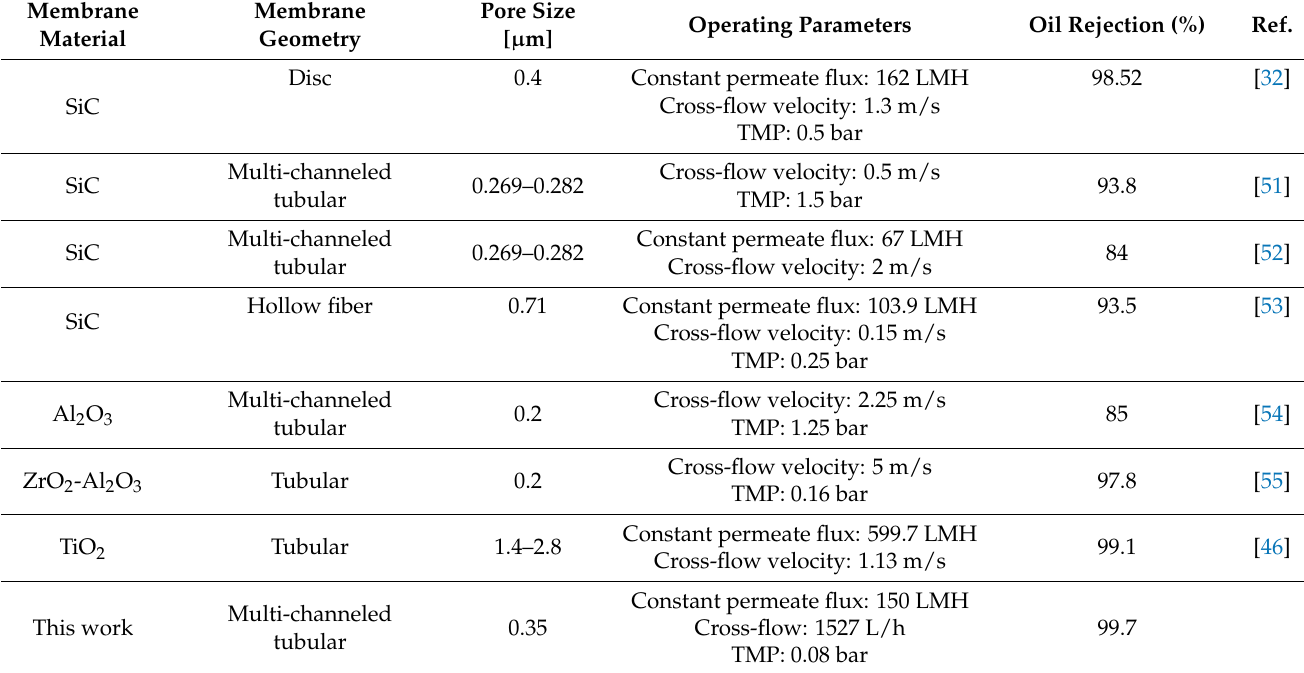
Table 1. Comparison of the oil removal performance of different ceramic membranes reported in the literature.